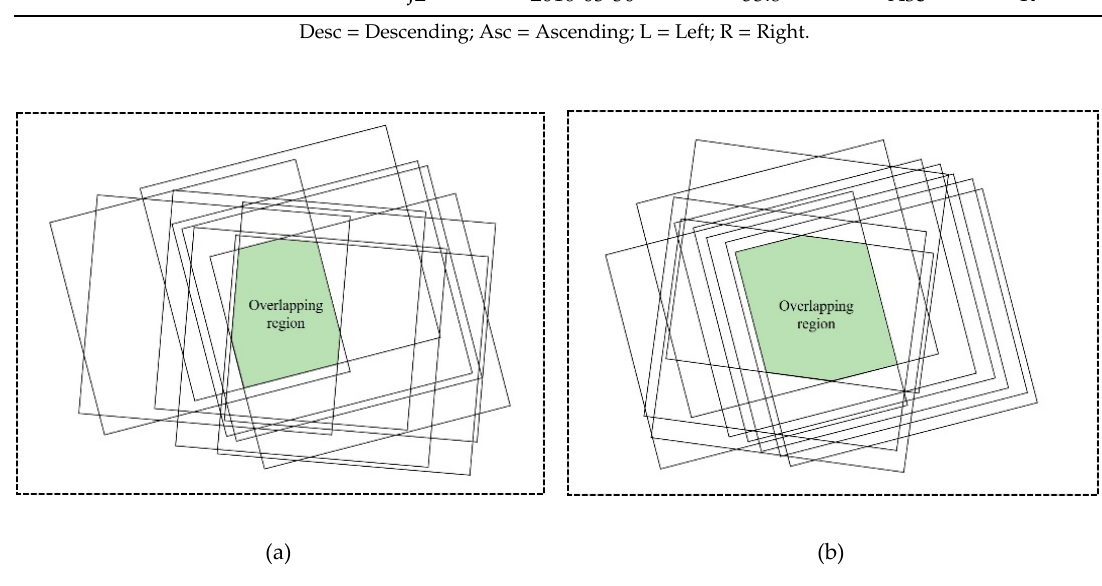
− 0.134 Table 4. Geometric calibration results for Calibration Group B (150 MHz and 24.4 μ s). Combination Slant Range Correction (m) Systematic Azimuth Shifts (ms)